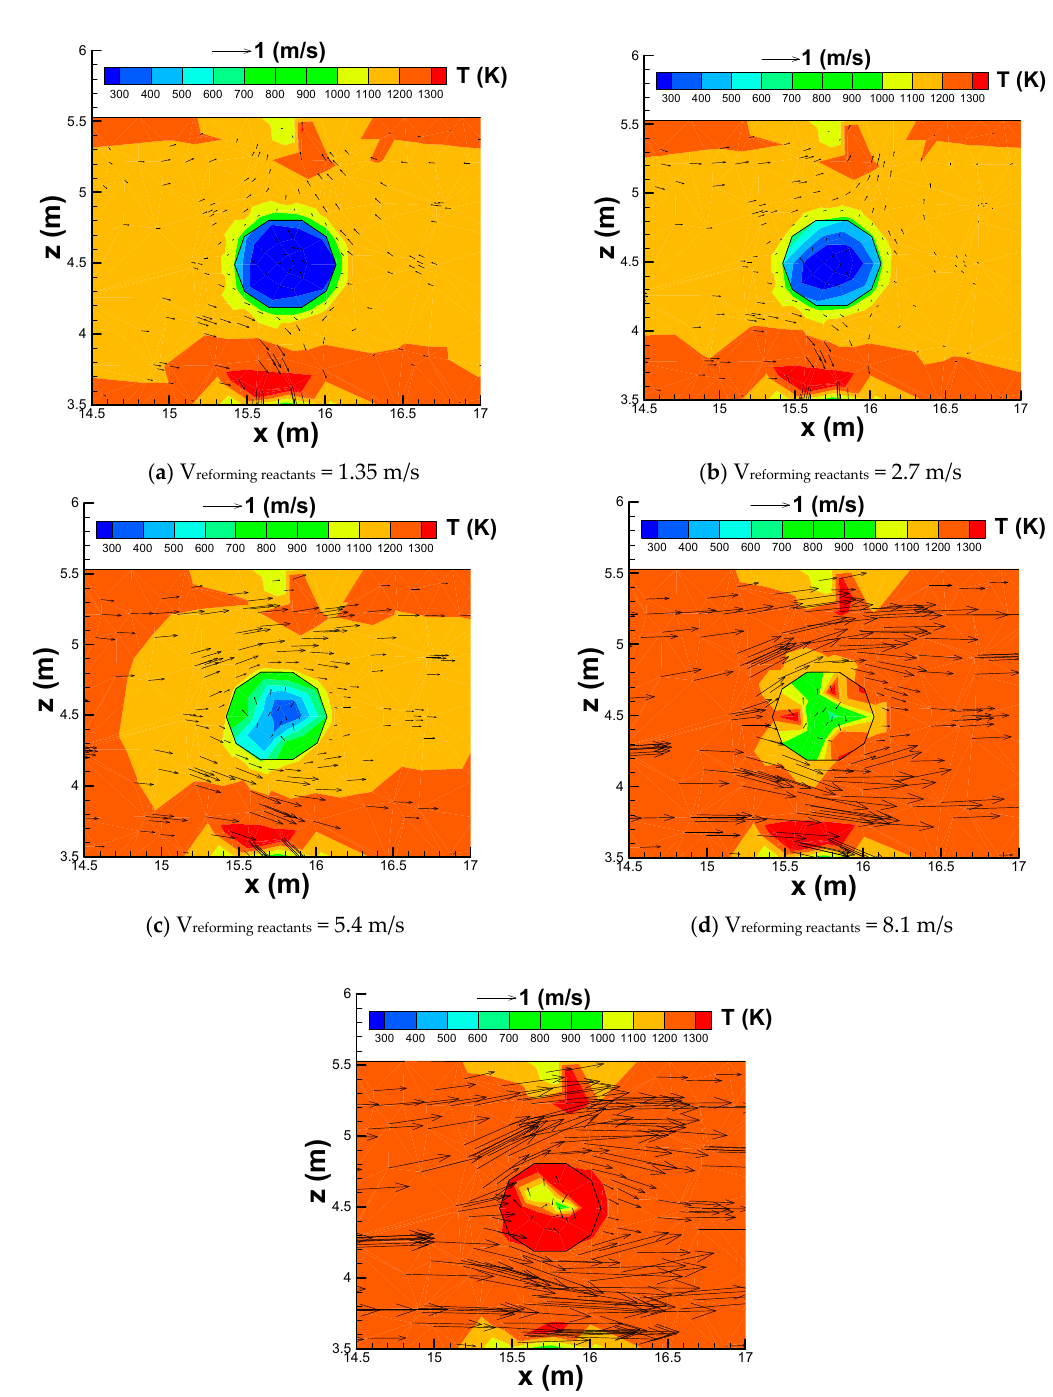
Figure 10. Comparison of the average wall shear stresses at the surfaces of the reforming tubes using different inlet velocities of the reforming reactants.